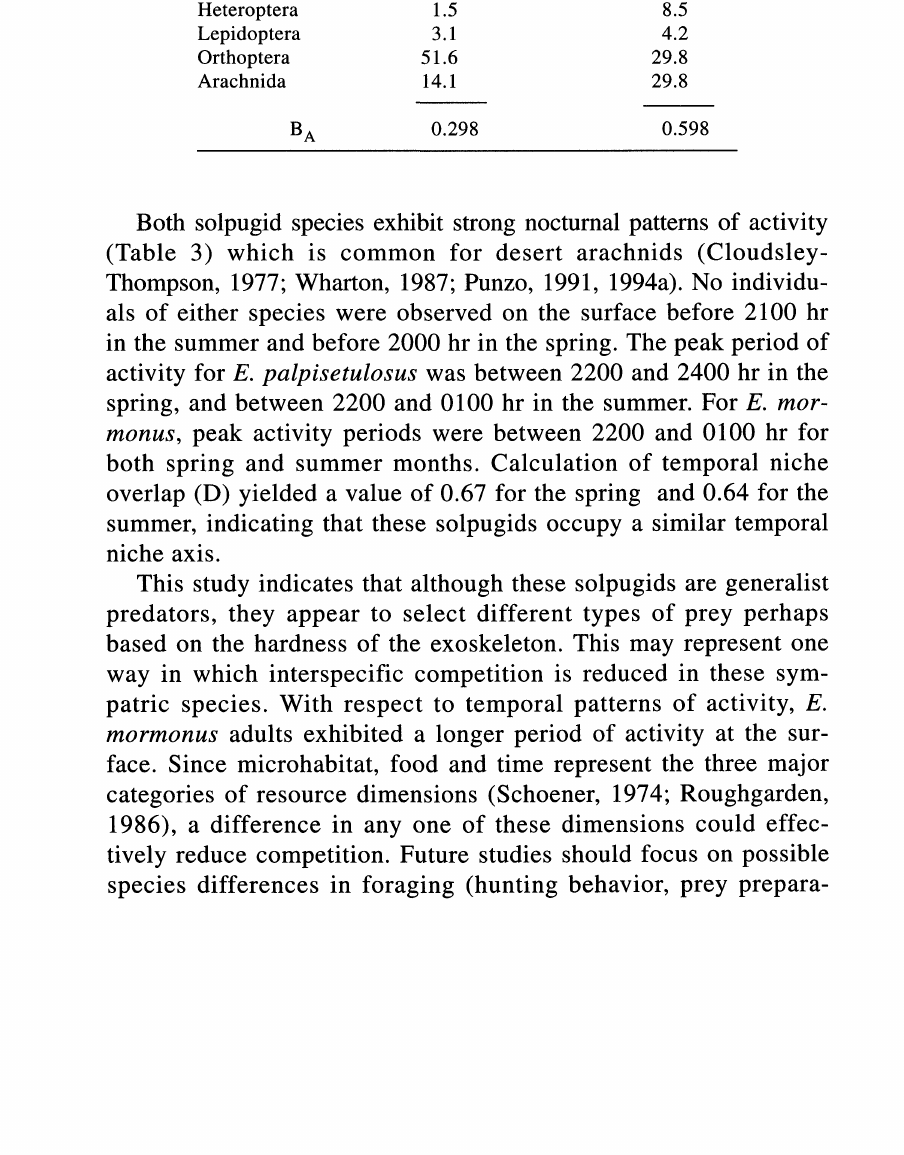
Table 2. Levins’ standardized measure of trophic niche breadth (BA) based on the percent frequency of occurrence of various prey